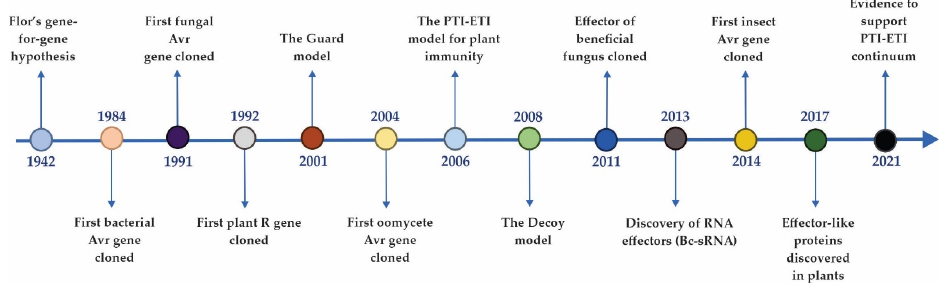
Figure 1. A timeline of some noteworthy milestones that shaped Effector Biology.